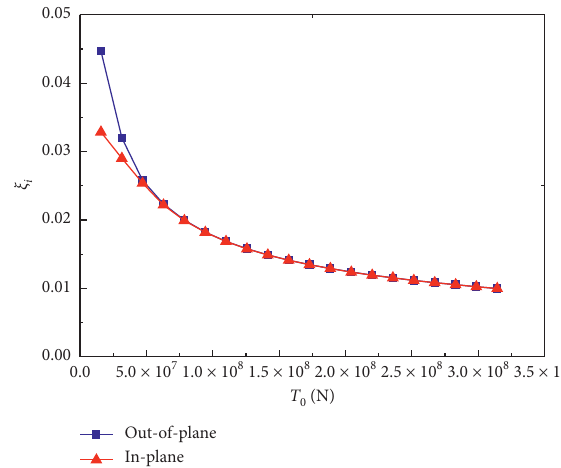
Figure 10: Relationship between modal damping ratios and initial tension of